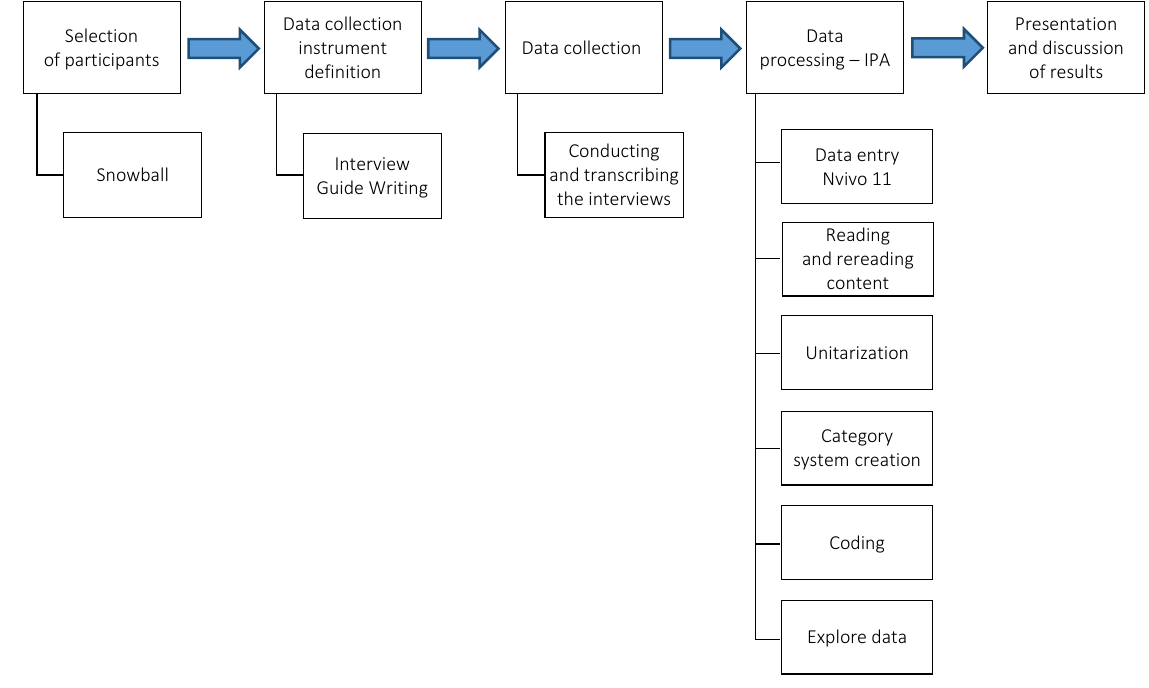
Figure 1. Research